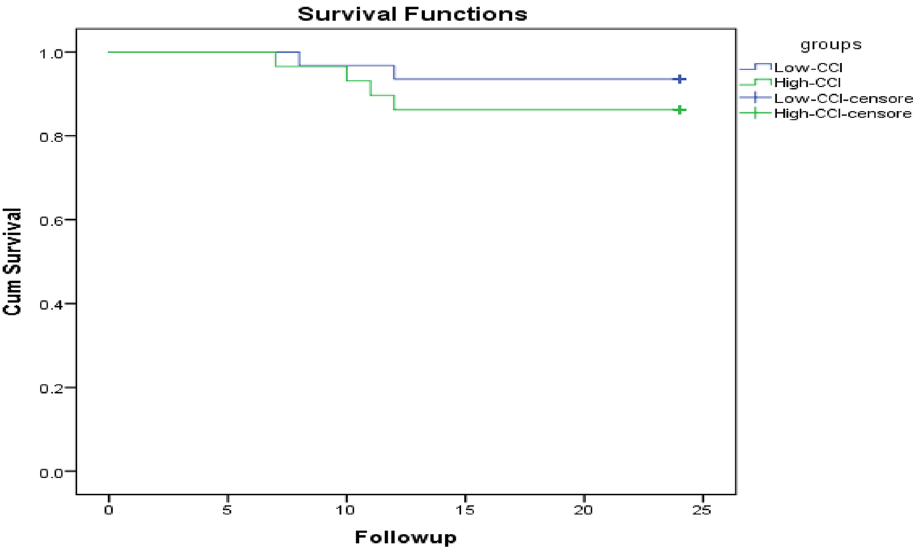
Figure 1. A Kaplan–Meier plots for overall survival for low-CCI group compared to high-CCI group. (Created by SPSS 24.0